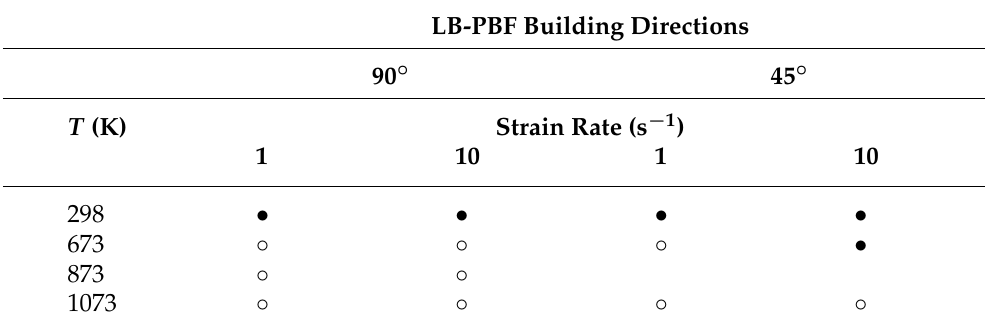
Table 2. Summary of the occurrence of adiabatic shear band ( • ) and highly deformed region ( ◦ ) during uniaxial compression of the Ti42Nb alloy manufactured with building direction of 90 ◦ and 45 ◦